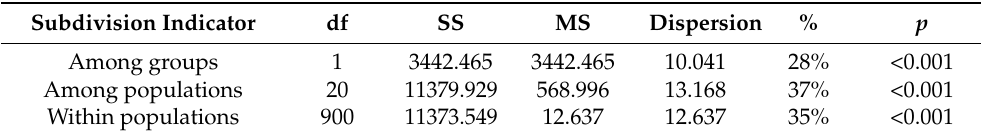
Table 3. Assessment of genetic intra- and interpopulation variability in P. sylvestris populations by AMOVA.